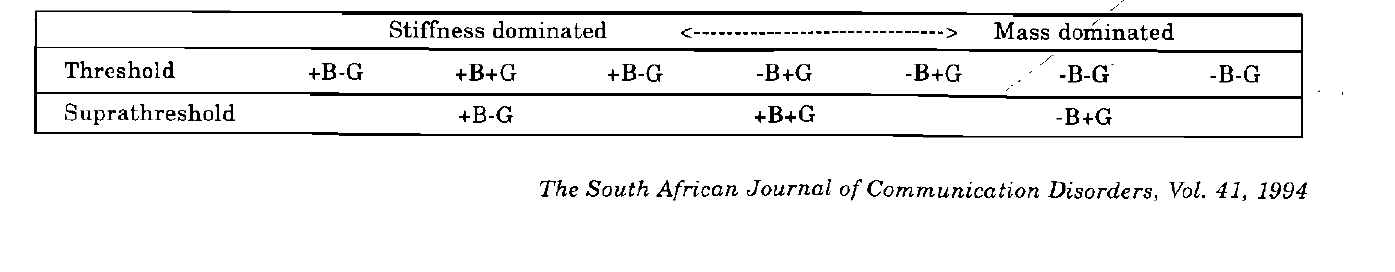
Table 3. Continuum of results obtained in the present study indicating the relationship between reflex patterns at threshold and suprathreshold intensity levels and baseline transmission properties (mass dominance vs stifness